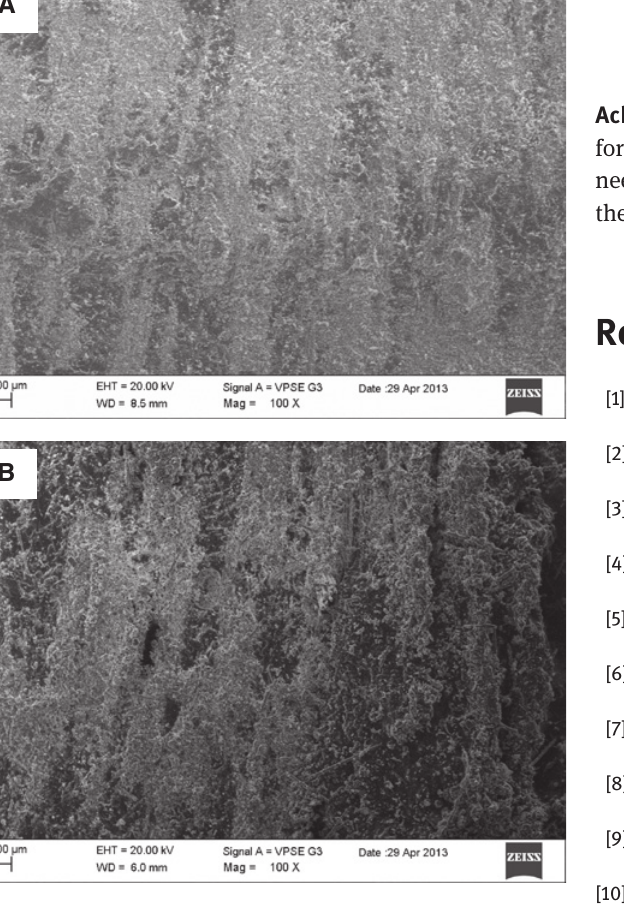
Figure 13 Worn surface morphology, run at 3.5 m s -1 with 30 N load: untreated composites (A) and alkali-treated composites